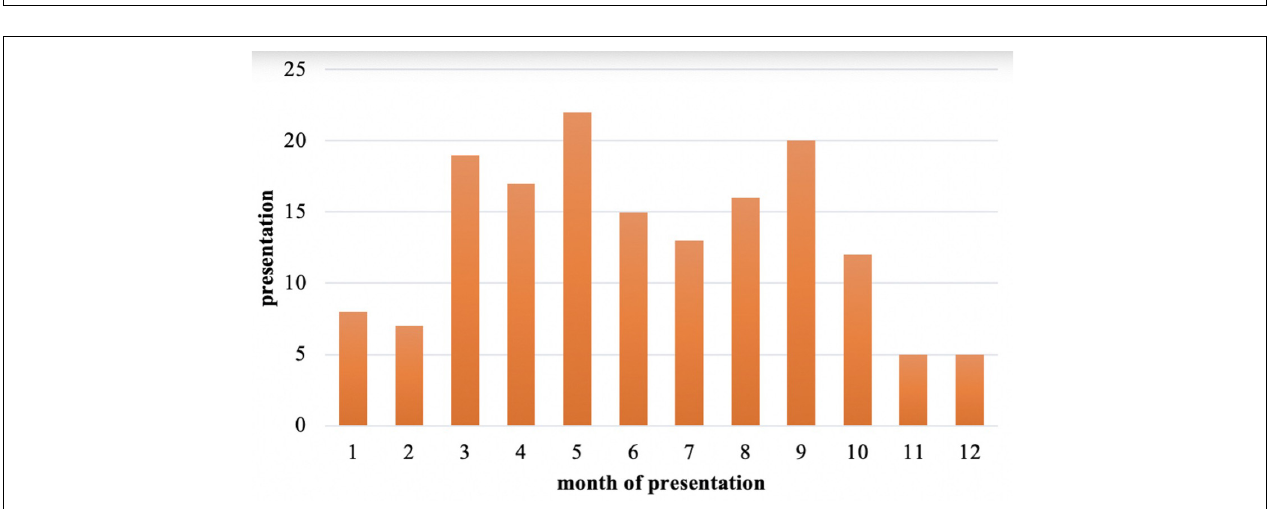
FIGURE 4 | Demographic characteristics of the study population: comparing the incidence of acute hepatitis E infection between males and females in different age stages.